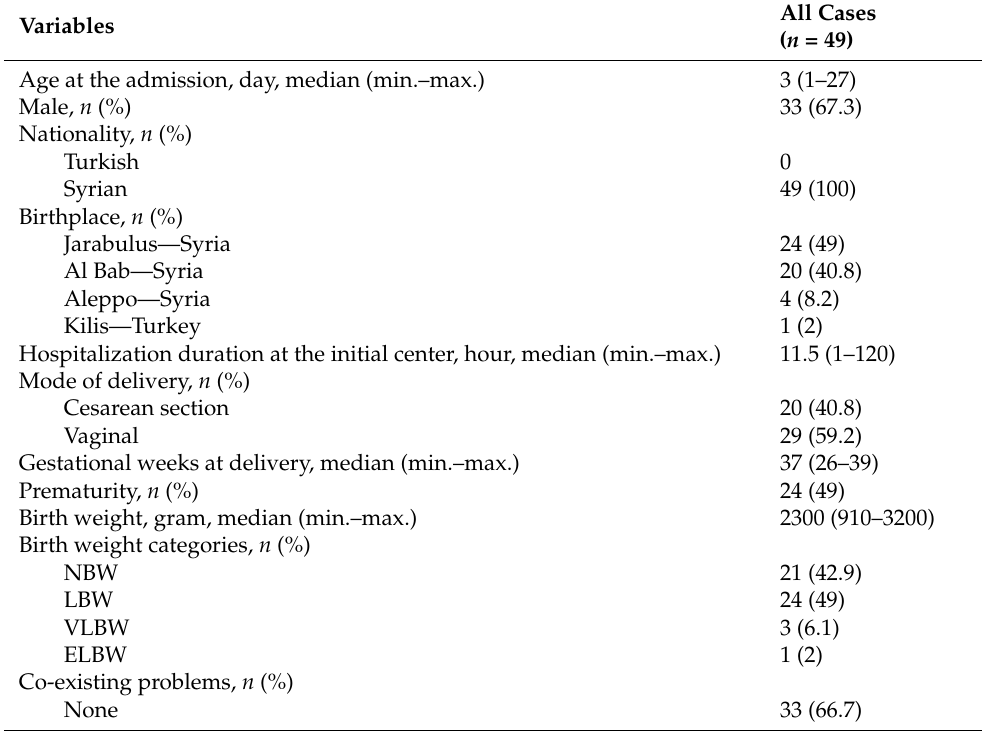
Figure 2. Distribution of the neonates with Burkholderia cepacia complex infections regarding birth- place and admission date. Table 1. Demographic characteristics and initial clinical features of the neonates with Burkholderia cepacia complex